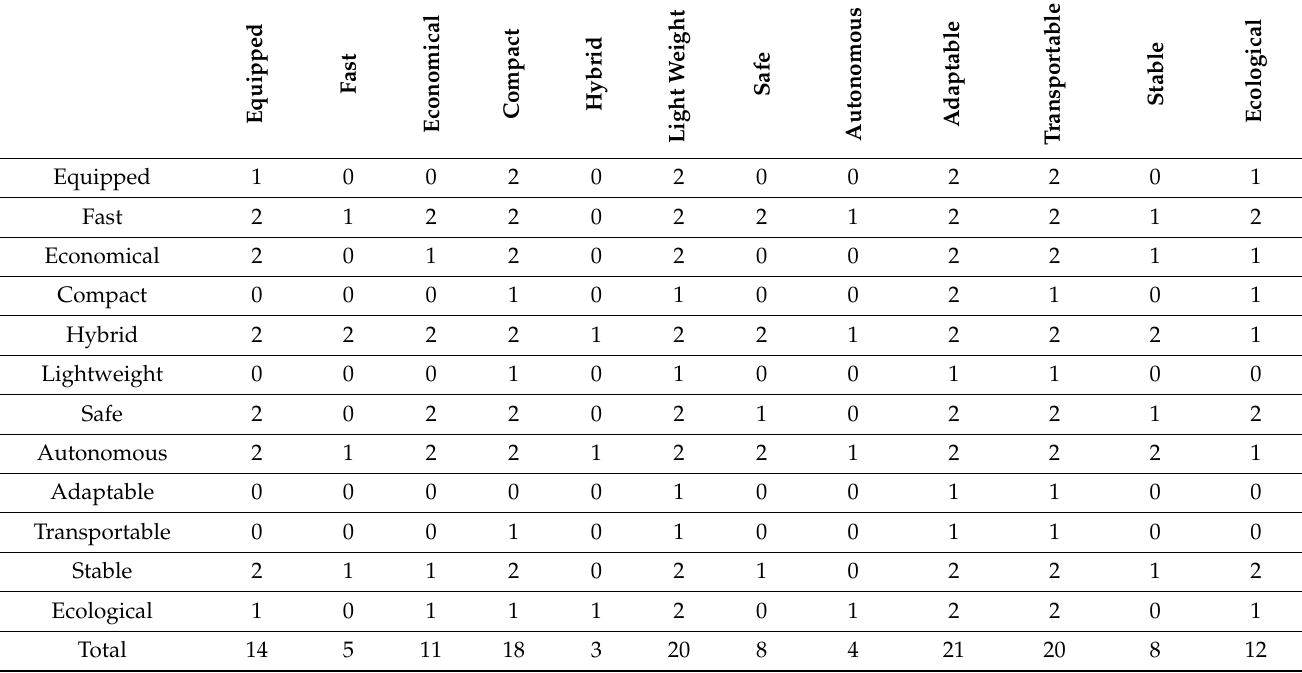
Table 1. Relative importance relationship